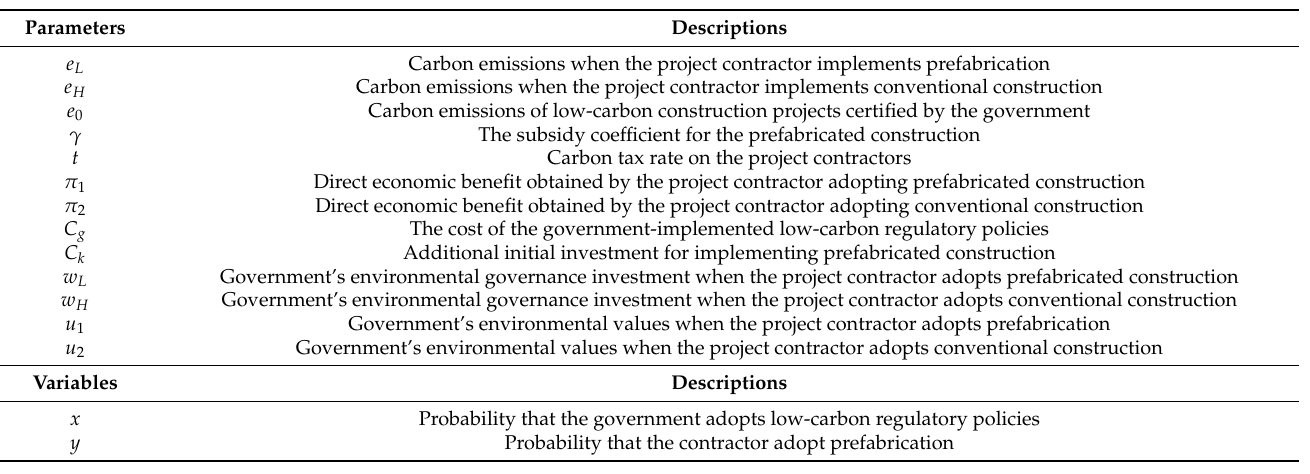
Table 1. Parameters and variables.